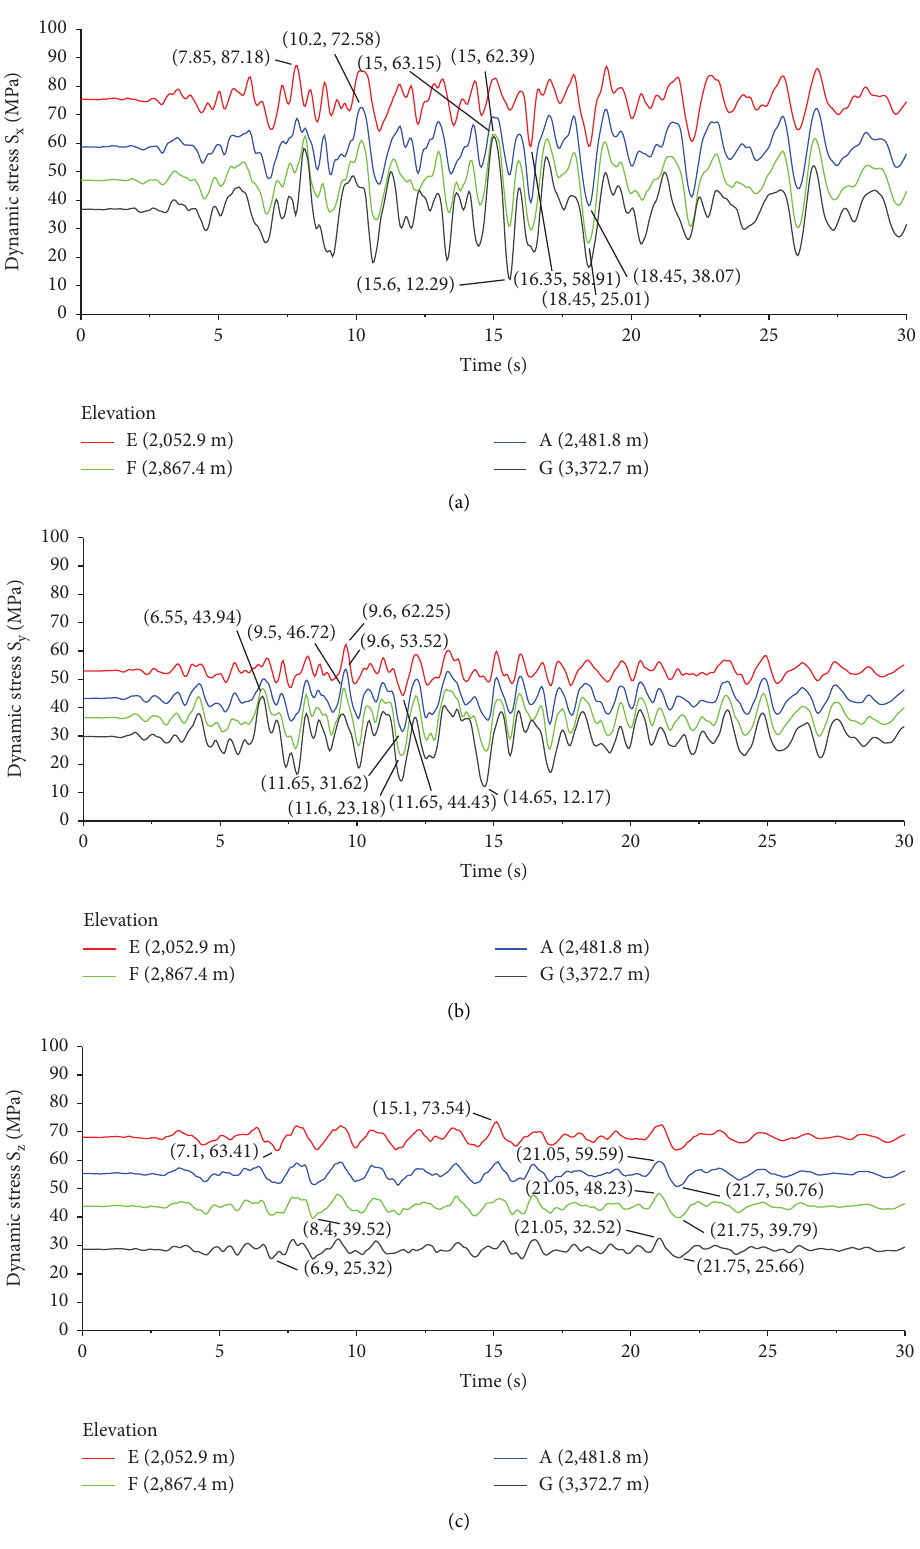
Figure 10: Dynamic stress change time-history curve. (a) S